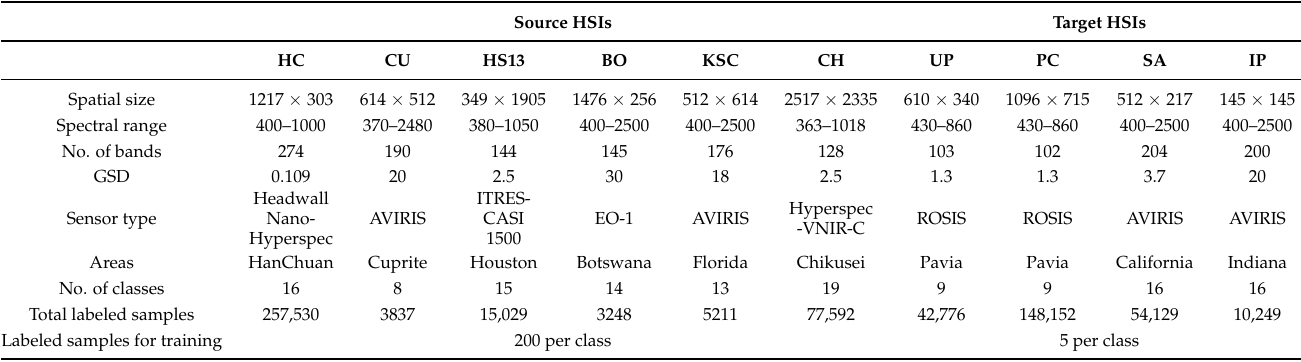
Table 1. Details of source HSIs and target HSIs. HanChuan (HC), Cuprite (CU), Houston 2013 (HS13), Botswana (BO), Kennedy Space Center (KSC), Chikusei (CH), University of Pavia (UP), Pavia Center (PC), Salinas (SA), Indian Pines (IP), ground sample distance (GSD)(m), spatial size (pixel), Spectral range (nm), airborne visible infrared imaging spectrometer (AVIRIS), reflective optics system imaging spectrometer